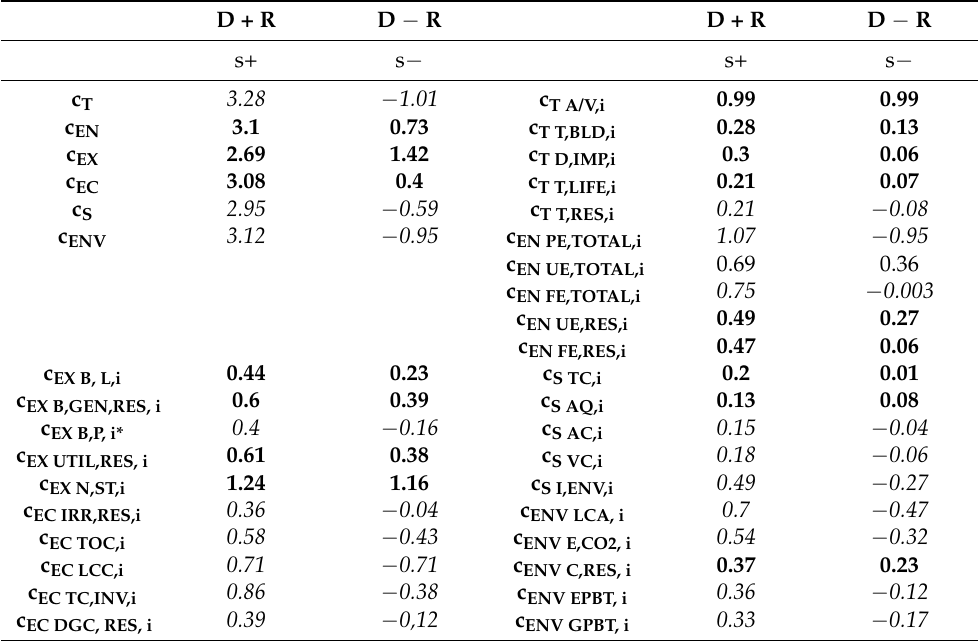
Table 1. The role and importance of individual main criteria and sub-criteria of evaluation. D + R D − R D +